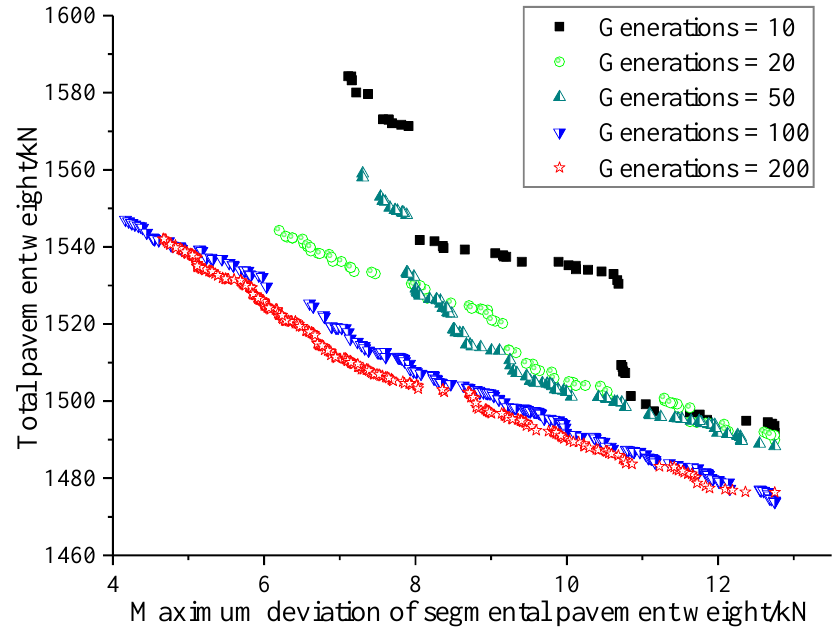
Figure 15. Pareto solutions in objective space.